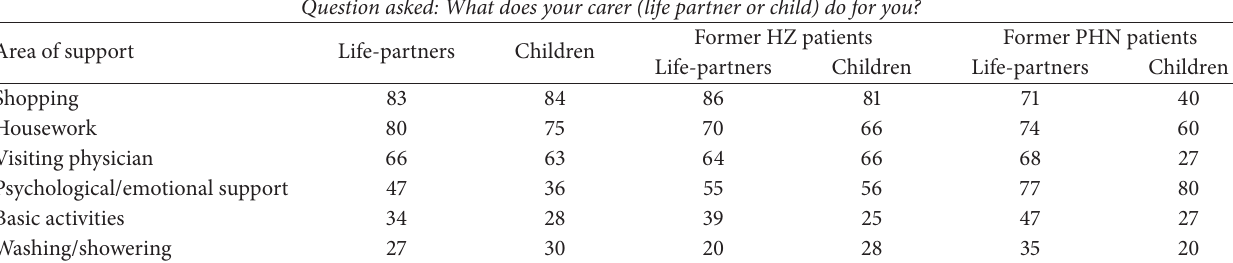
Table 2: Perceived importance of the different areas of support by the carers (life partner or child) and former HZ and PHN patients. The data for the former patients is given as a function of who cared for them, either life-partner or child. The data are the percentages of participants who said the area of support was